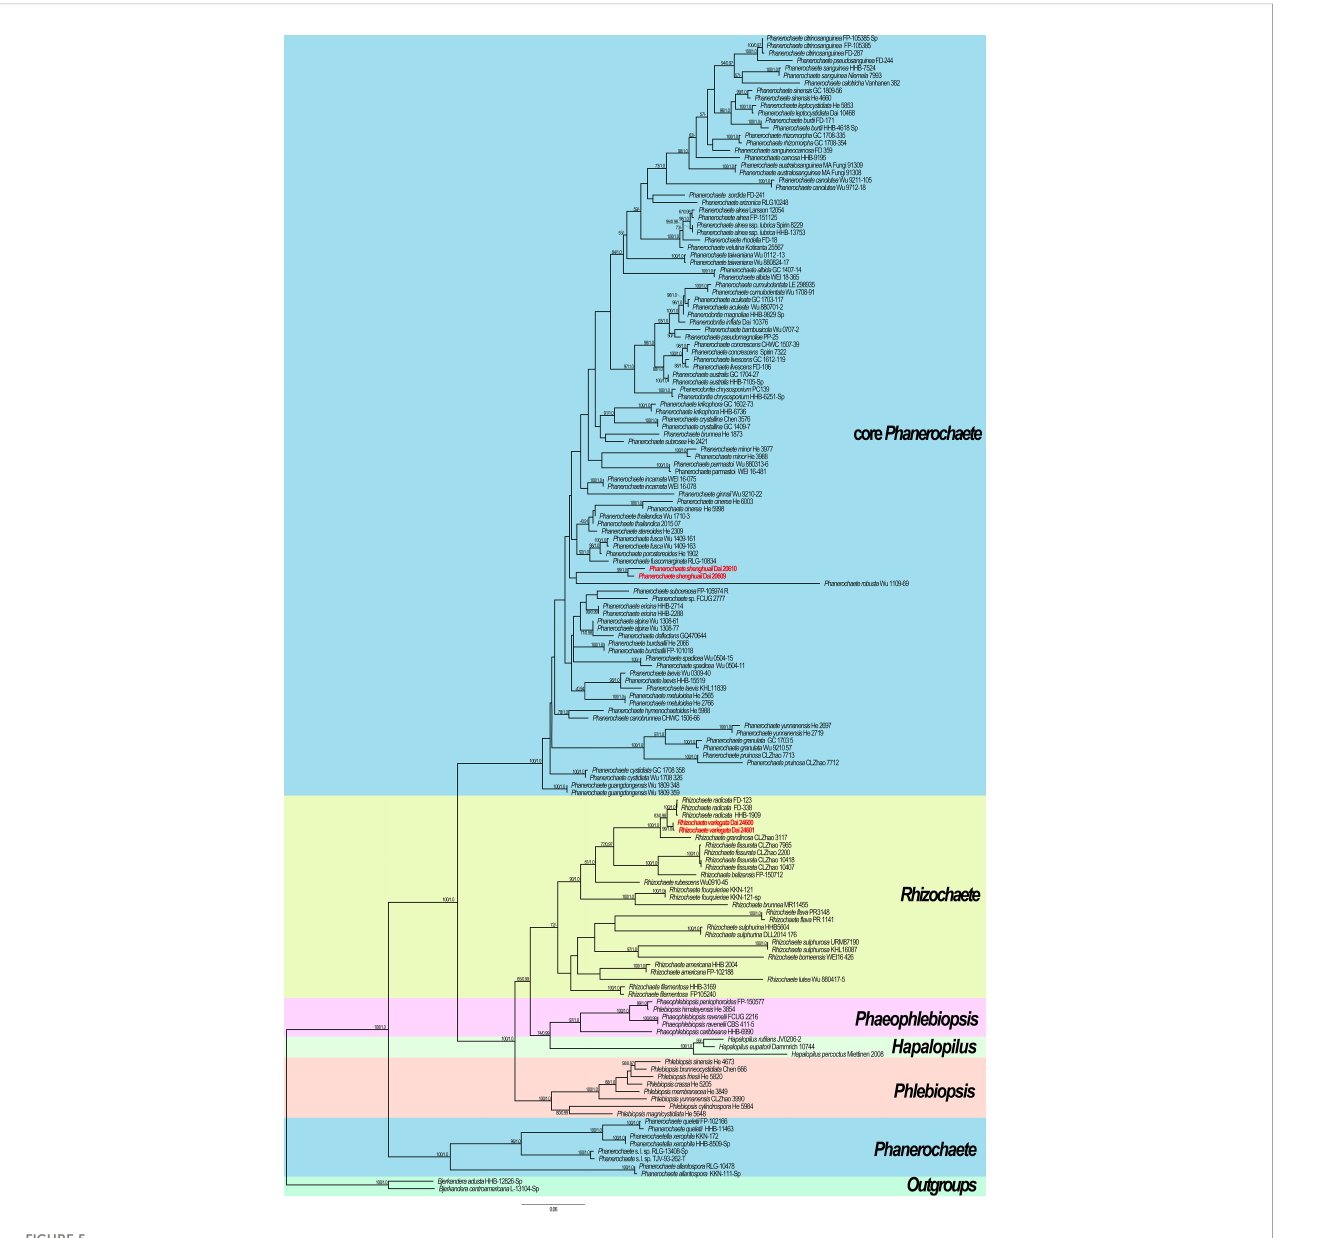
FIGURE 5 Maximum likelihood (ML) tree illustrating the phylogeny of the two new species in Phanerochaetaceae based on ITS + nLSU sequences. Branches are labeled with ML bootstrap >50% and Bayesian posterior probabilities (BPP) >0.90, respectively. New species are highlighted by red